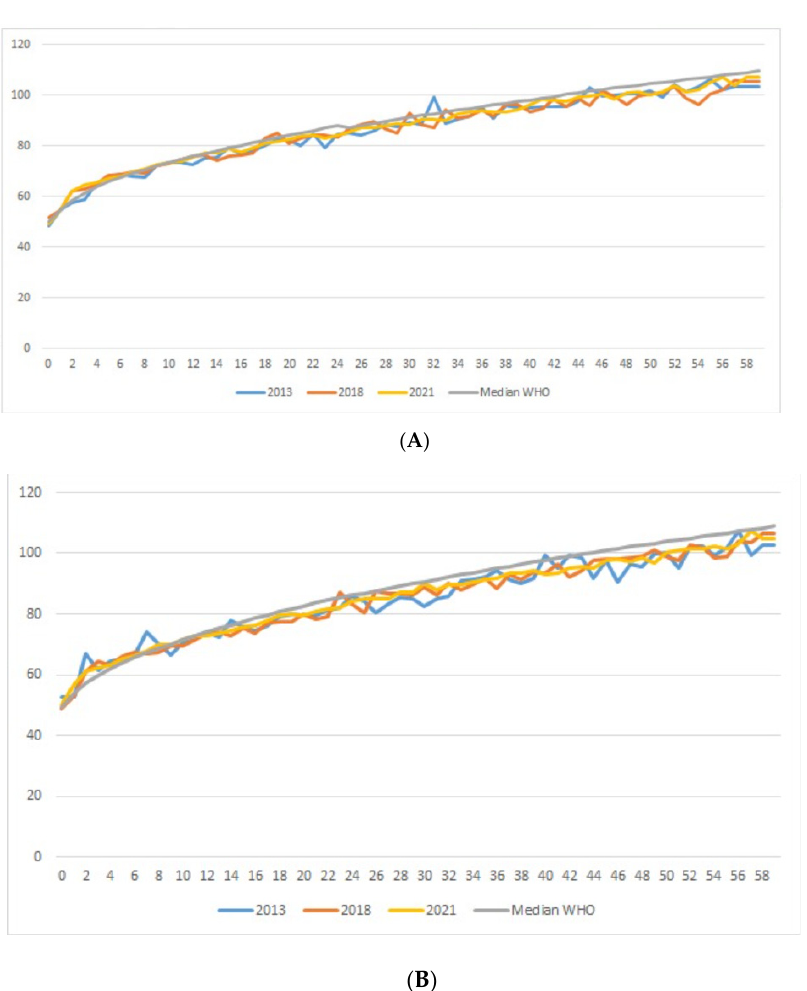
Figure 5. ( A ) Trend of average length/height of male toddlers in Yogyakarta, 2013–2021. ( B ) Trend of average length/height of female toddlers in Yogyakarta, 2013–2021. Although there was a decrease in stunting, the COVID ‐ 19 pandemic contributed to acute malnutrition in the form of stunting ‐ concurrent wasting (Figure 6). 2530 Figure 6. Trend of stunting and its concurrence in Yogyakarta, 2013–2021. 3.3. Program Intervention The program for tackling stunting in children includes sensitive and specific inter ‐ ventions. Sensitive interventions address indirect stunting causes outside health issues, including improvement of drinking water and sanitation facilities, nutrition and health services, nutrition knowledge, and nutritious food access. Specific interventions are activ ‐ ities that directly address the causes of stunting and are generally provided by the health sector, such as food intake, infection prevention, maternal nutritional status, infectious disease treatment, and environmental health. In fact, the coverage of intervention pro ‐ grams, both sensitive and specific, increased year by year from 2018 to 2021 (Figure 7A,B). 0 51015 20